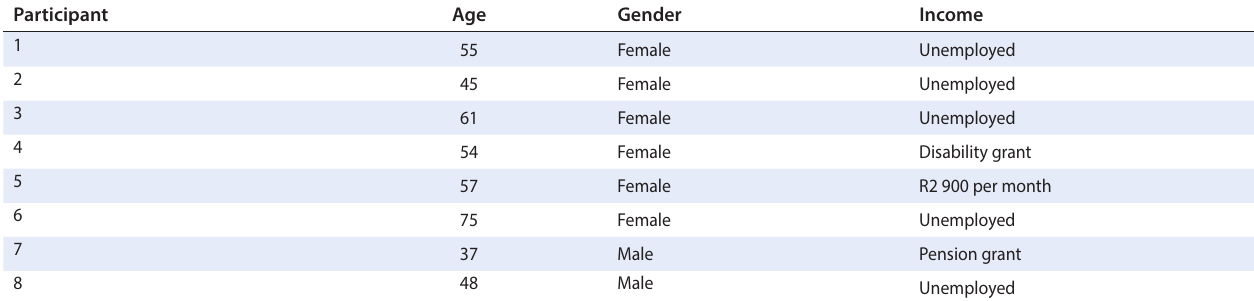
Figure 1: The findings of this study Table 1: Focus group interview 1